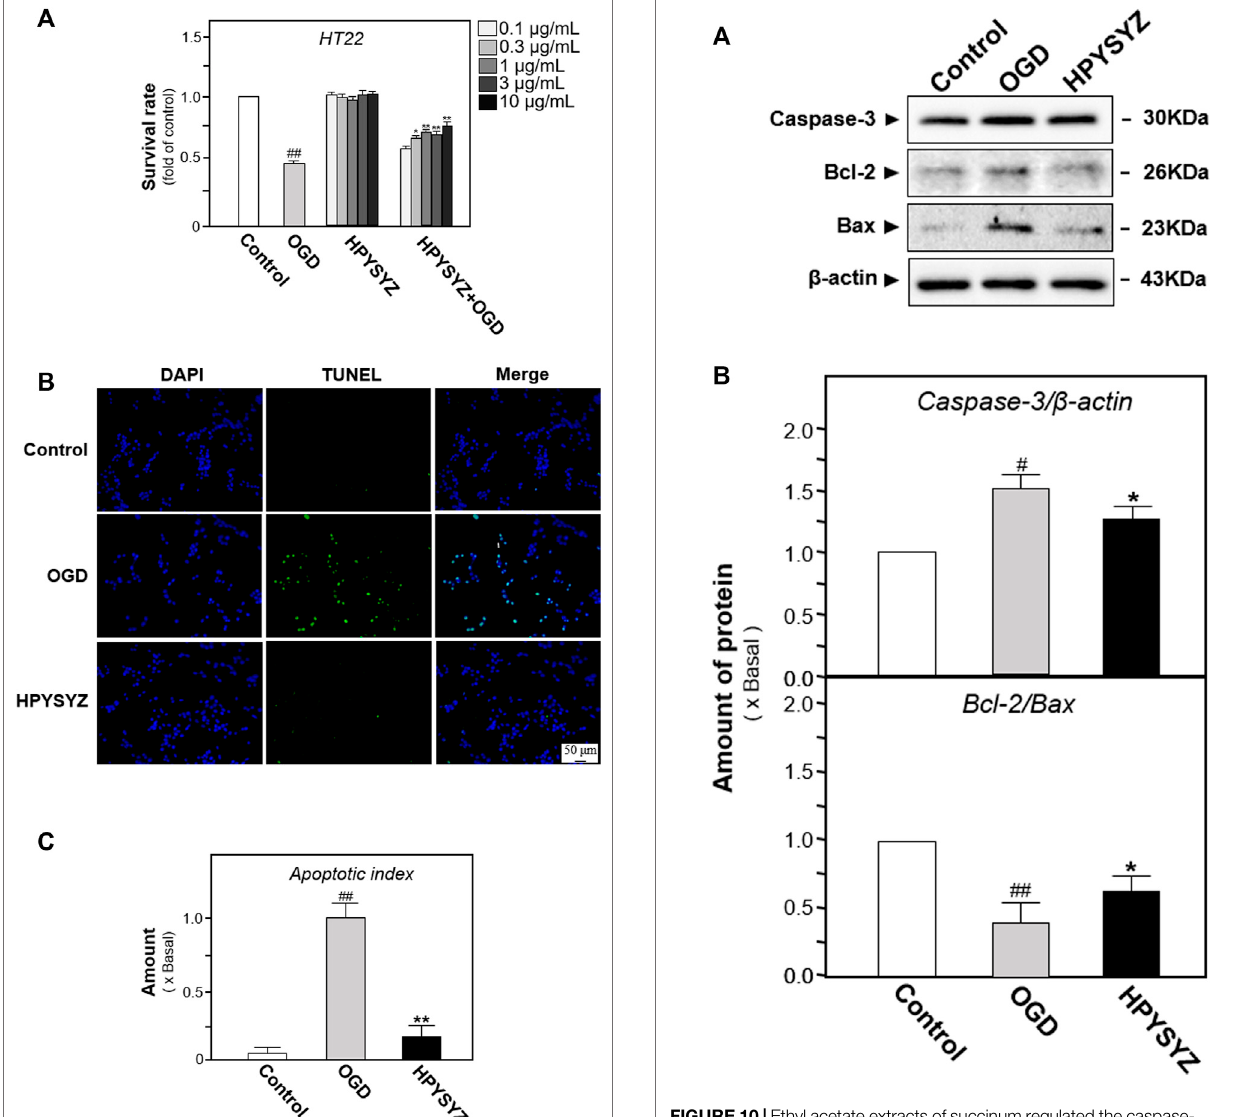
of ethyl acetate extracts of succinum decreased the expression of apoptotic proteins rat compared with the model group ( p < 0.01).